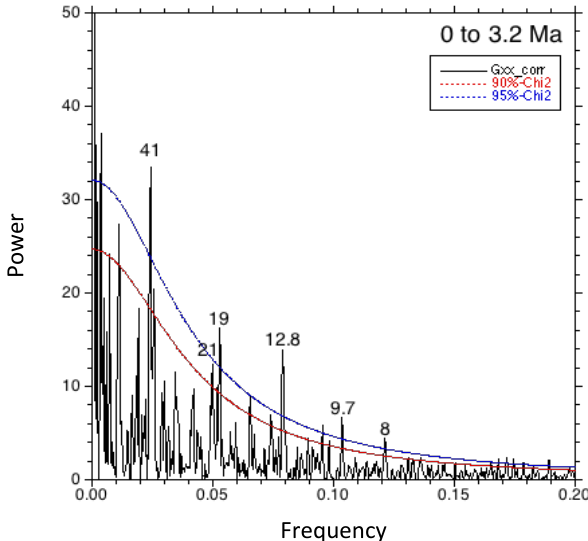
Figure 6. Multitaper method power spectrum of bulk δ 18 O using REDFIT (Schulz and Mudelsee, 2002). The signal contains partic- ularly strong power at periods of 41, 19–21, 12.8, 9.7, and 9kyr. The power at 21 and 19kyr may not entirely represent precession because, in the 41kyr world, bulk δ 18 O minima tend to occur at the onset and end of glacial cycles, which can result in a semi-obliquity peak near